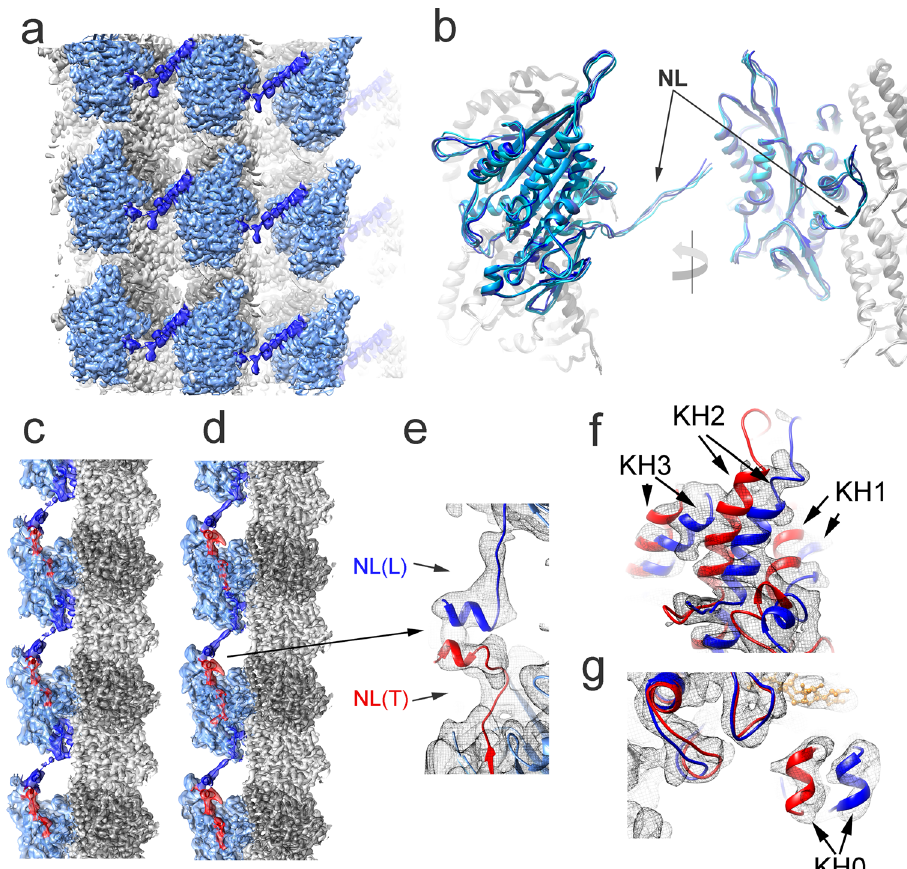
Fig. 6 KIF14 dimer one- and two-heads microtubule-bound states. a Iso-density surface representation of nine adjacent asymmetric units of the helically averaged MT-K755-ADP cryo-EM map colored according to the fi tted atomic model regions. The KIF14 motor domain and neck-linker are colored light and dark blue, respectively. b Superimposed MT-K755-ADP, MT-K755-Apo, MT-K772-ADP, and MT-K772-Apo structures. All the structures aligned to their corresponding β -tubulin chains. The KIF14 motor domain of each model is colored in a different shade of blue. NL: neck-linker. c MT-K772-ANP helically averaged cryo-EM map. d MT-K755-ANP helically averaged cryo-EM map. In ( c ) and ( d ), the KIF14 motor domain is colored blue with docked and undocked neck-linker regions colored red and dark blue, respectively. e Detail of the connecting neck-linkers and part of the coiled coil region of trailing (red) and leading (blue) KIF14 motor domain structures fi tted into the MT-K755-ANP helically averaged cryo-EM map (gray mesh). f , g MT-K755-ANP helically averaged cryo-EM map (gray mesh) with fi tted open (blue) and closed (red) conformations of the KIF14 motor domain. f Shows the region of the motor domain with helices 1, 2, and 3 (KH1, KH2, KH3). g Shows the motor domain region near helix-0 (KH0). α - and β -tubulin regions colored light and dark gray, respectively, in ( a – d